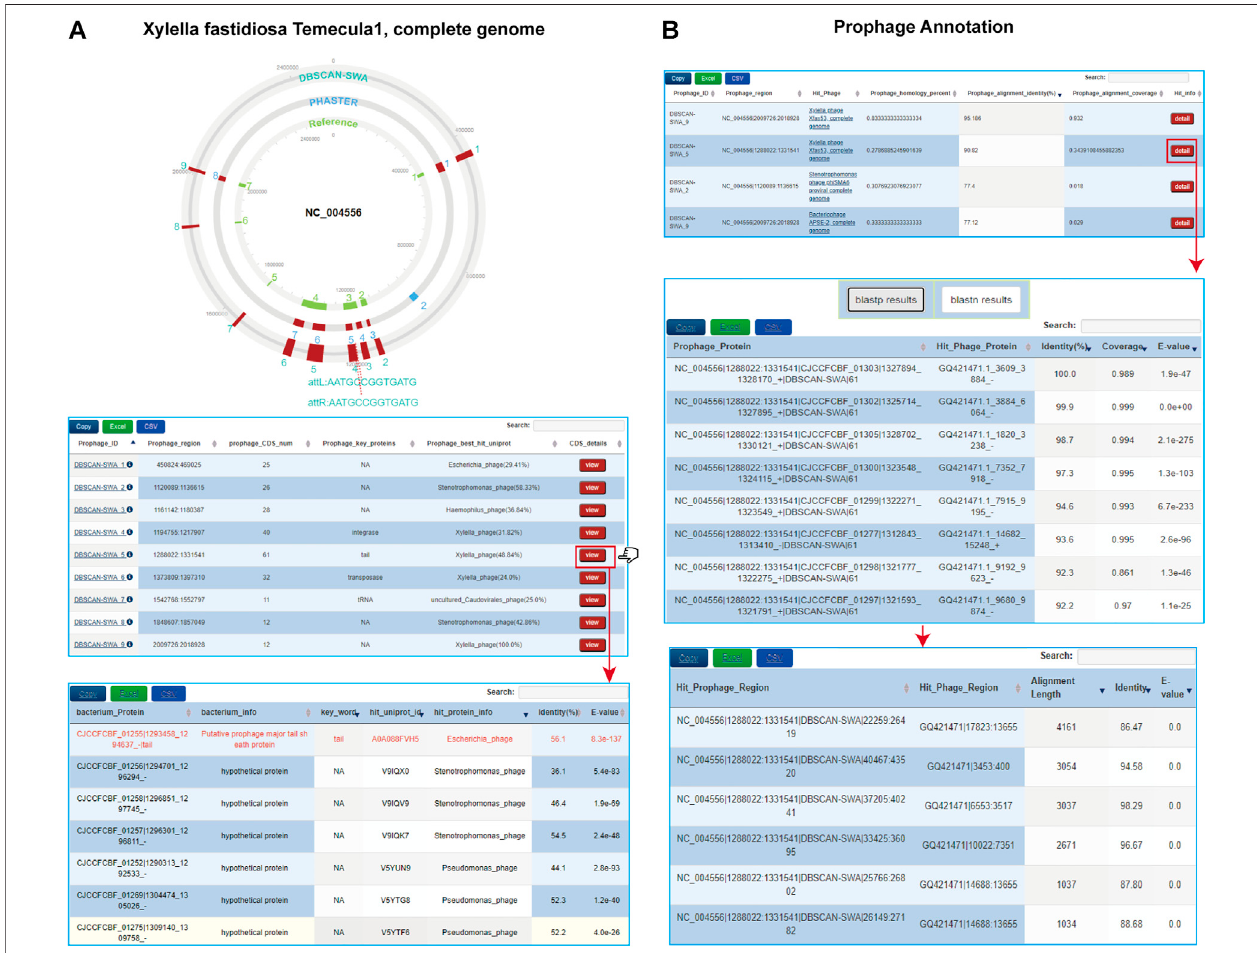
FIGURE 2 | Visualizations of DBSCAN-SWA for prophage detection. (A) Interactive XHTML visualization of predicted prophages for Xylella fastidiosa Temecula1 (NC_004556) including a circular prophage viewer to display colored prophage regions with att sequences and interactive tables to display the detailed information of each prophage. (B) Interactive tables to display the predicted infecting phages and hit information for Xylella fastidiosa Temecula1 by using the parameter: “ --add annotation PGPD ” .